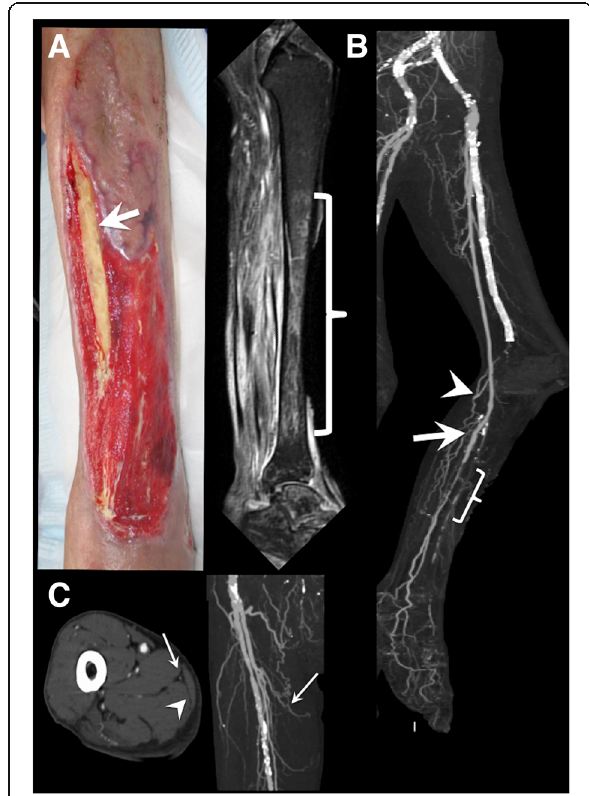
Fig. 2 a Two months after initial surgery. A photograph showing the exposed surface of the tibia even with good granulation around the area. Magnetic resonance imaging showed osteomyelitis of the tibia (bracket). b Postoperative computed tomography showed patent bypasses to the sural artery (arrowhead) and posterior tibial artery (arrow). Native artery stenosis was detected distal to the anastomosis (bracket). c The gracilis muscle (arrowhead) and the pedicle (arrow) of the contralateral leg that originated from the medial femoral circumflex artery